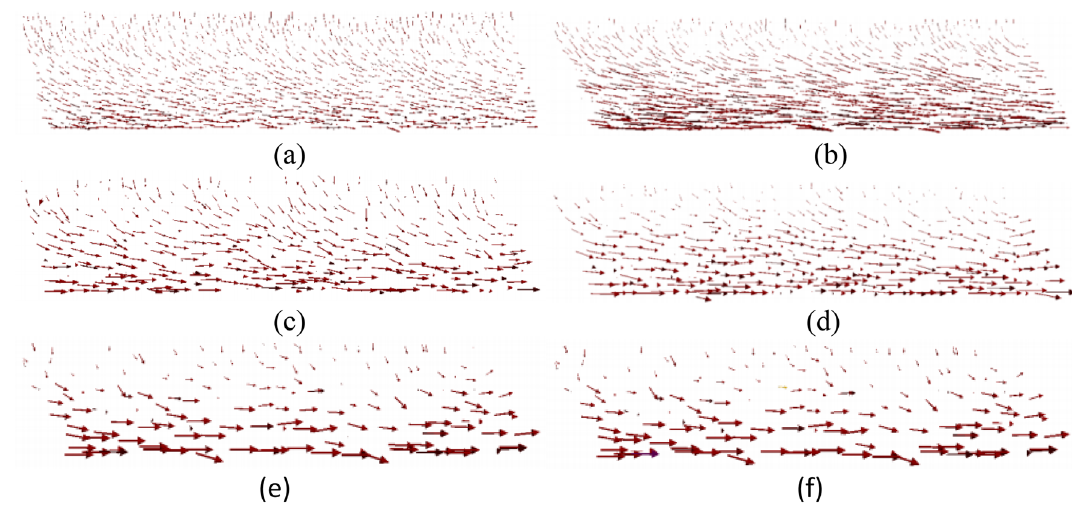
Figure 7. Incremental displacement vectors for global shear strain interval (Front view): ( a )1D 20% shear strain, ( b ) 1D 40% shear strain, ( c ) 2D 20% shear strain, ( d ) 2D 40% shear strain, ( e ) 4D 20% shear strain, ( f ) 4D 40% shear